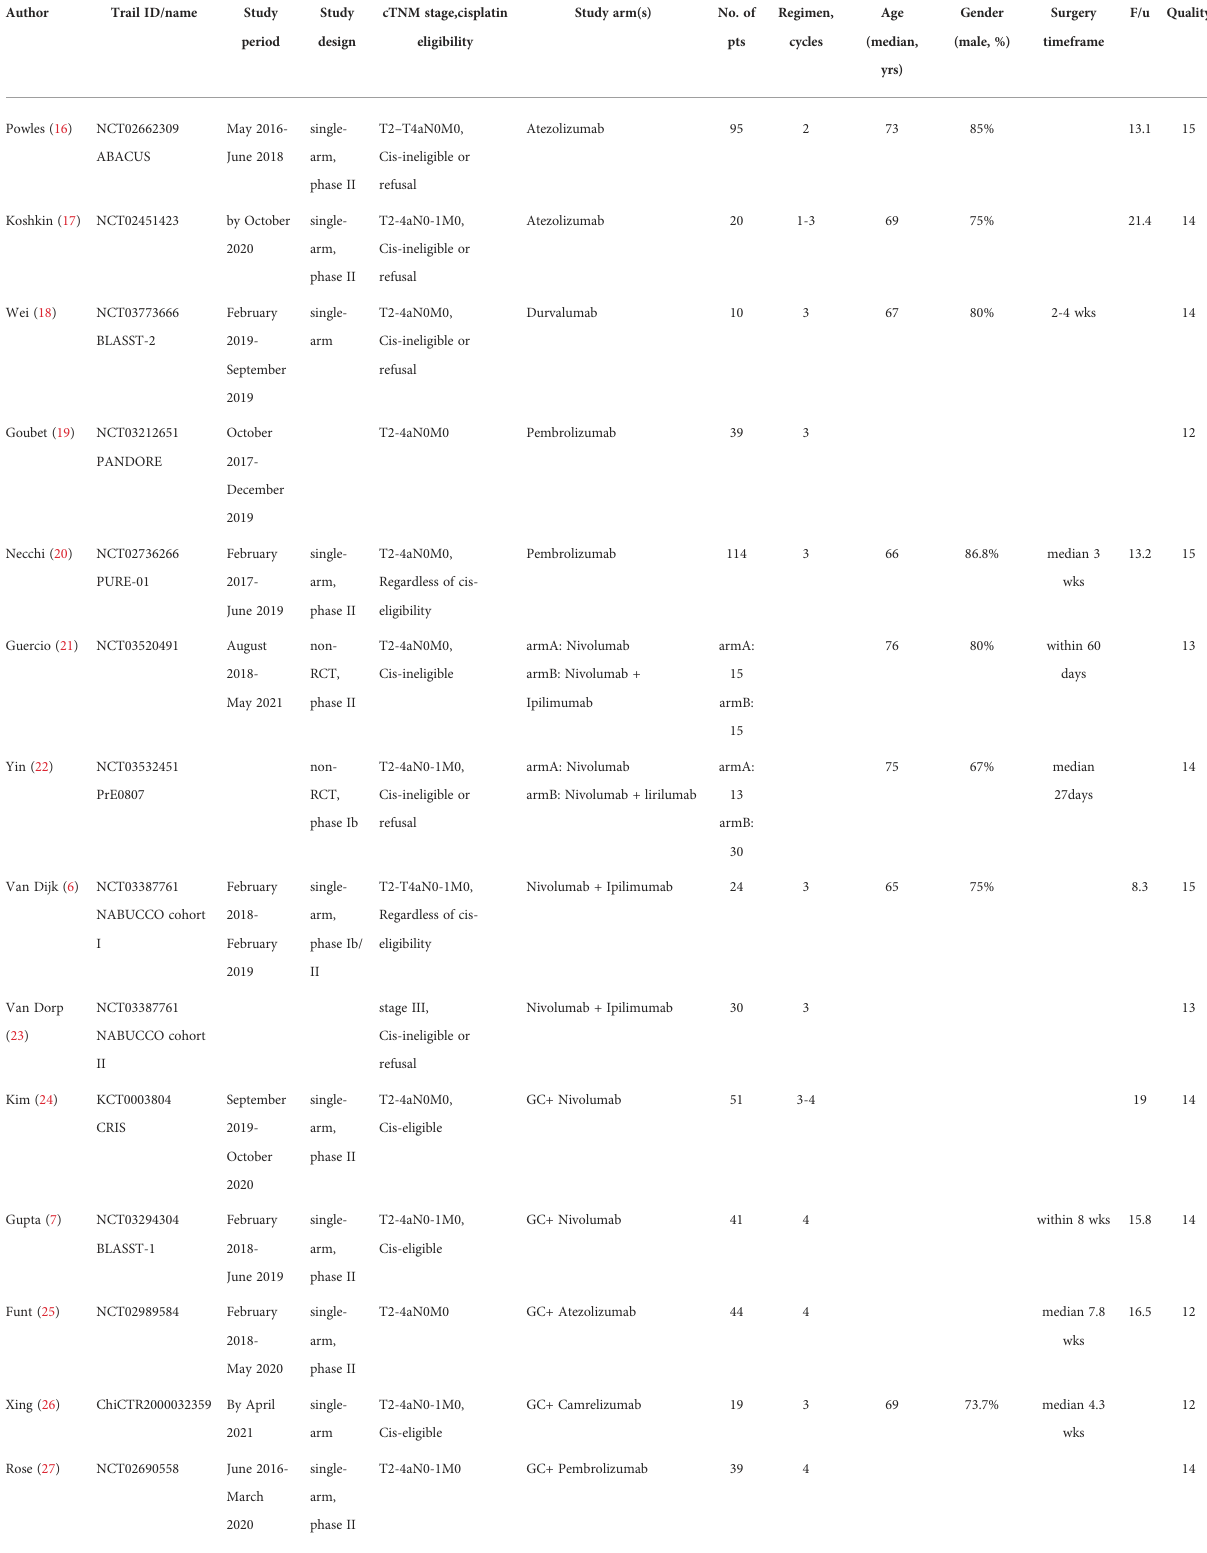
TABLE 1 Characteristics of included studies and